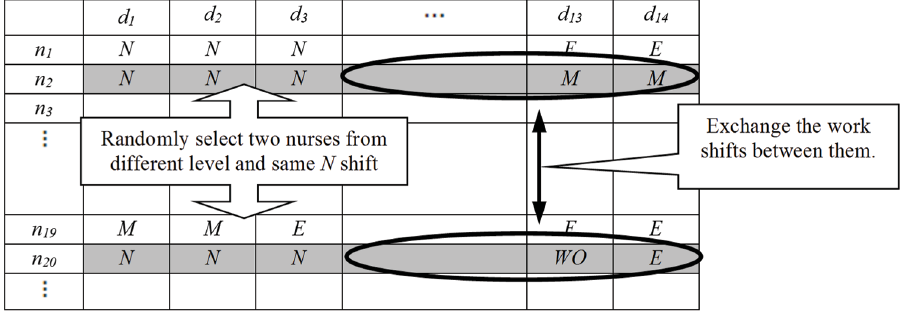
Figure 3. The possible representation of solution W ( l ) for a partial solution.